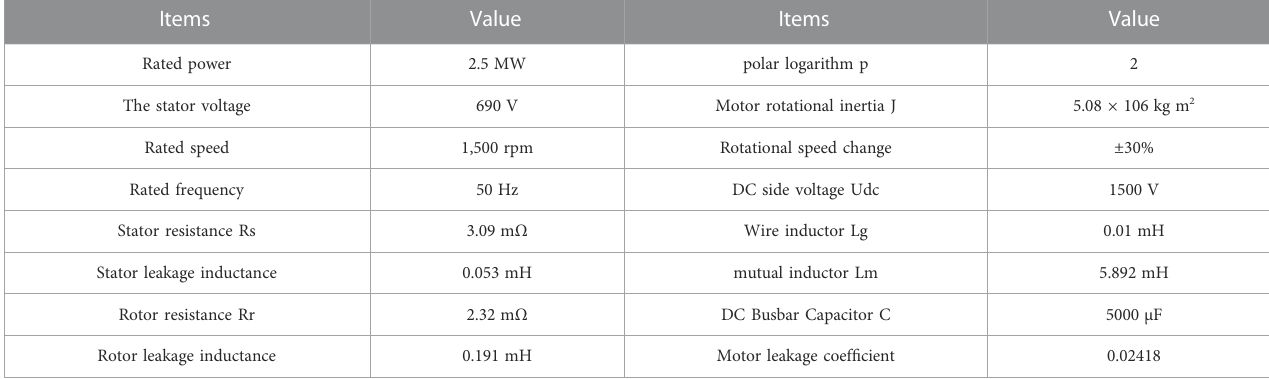
TABLE A2 Parameters of the doubly-fed induction generator model in the